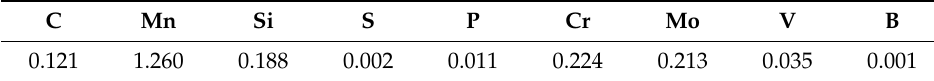
Table 2. Chemical composition of CF62 (wt.%).